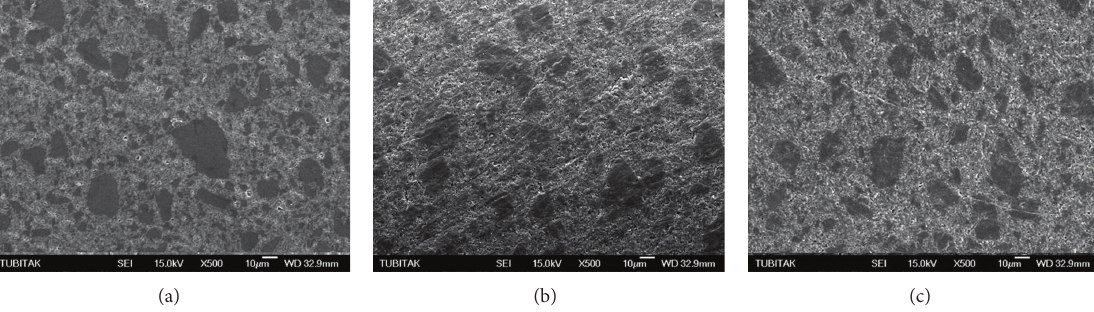
Figure 2: (a) Scanning electron micrograph of GRD-C showed prepolymerized, ceramic, and silica fillers with some debonding. (b) GRD-DT group revealed roughening of prepolymerized fillers along with resin abrasion between the fillers. Debonding of inorganic fillers was also evident. (c) GRD-TP showed similar surface morphology as the GRD-DT, however roughening of prepolymerized fillers was not as much as that in DT group.